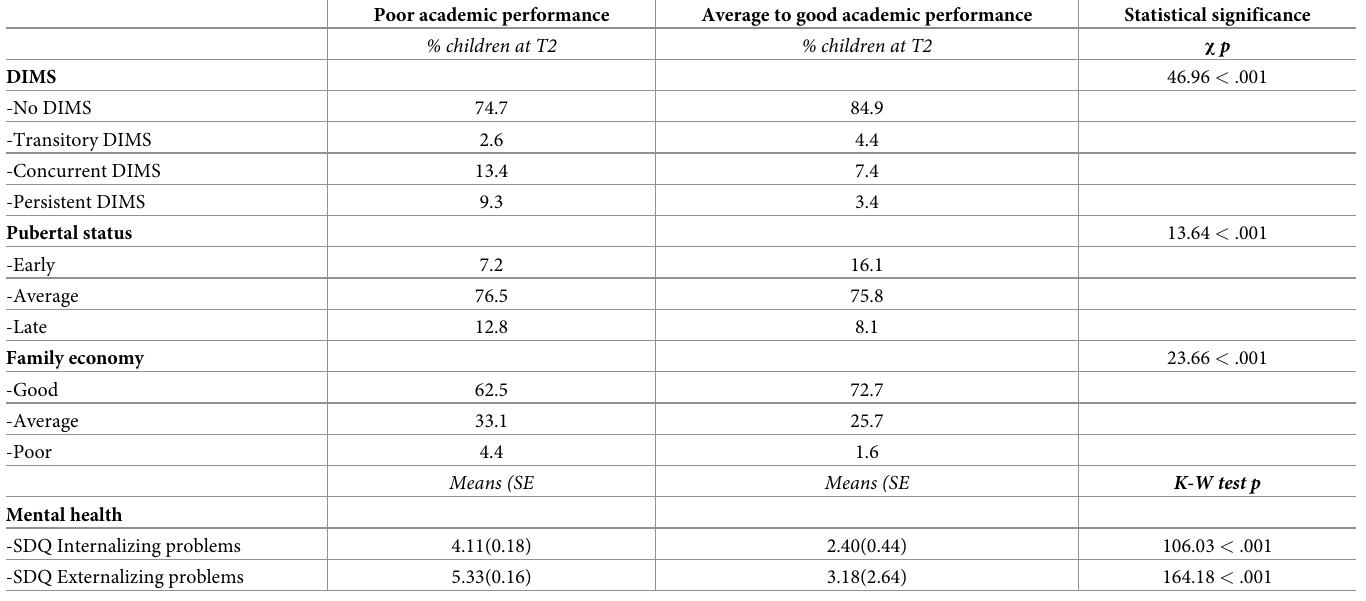
Table 1. Sample characteristics. Differences in the distribution of DIMS, pubertal status, family economy and mental health scores between children with poor academic performance and children with average-to-good academic performance. Poor academic performance Average to good academic